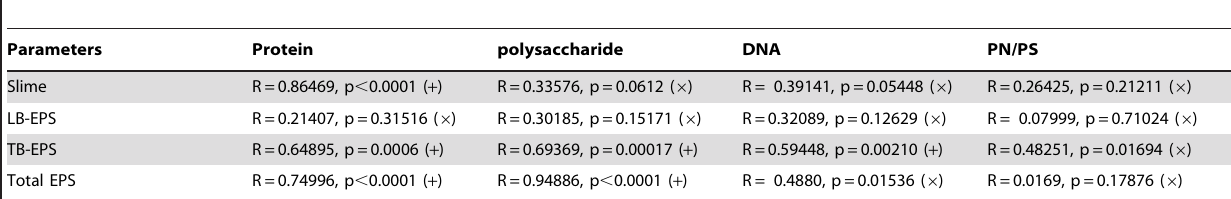
Table 2. Pearson correlations between sludge CST and the content of protein (a), polysaccharide (b) and DNA (c), or PN/PS (d) from Slime, LB, TB, Slime + LB + TB layer of sludge in the two controls and one bioleaching treatment systems.